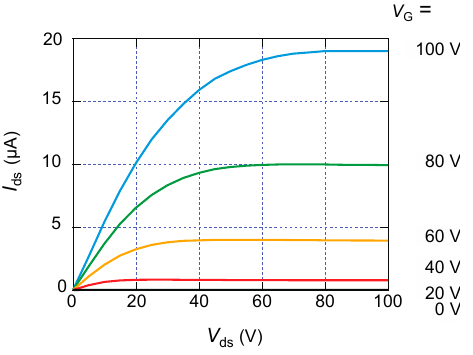
Figure 6. Current–voltage characteristics of the F 8 CuPc n-channel transistor in high vacuum (less than 10 − 2 Pa).